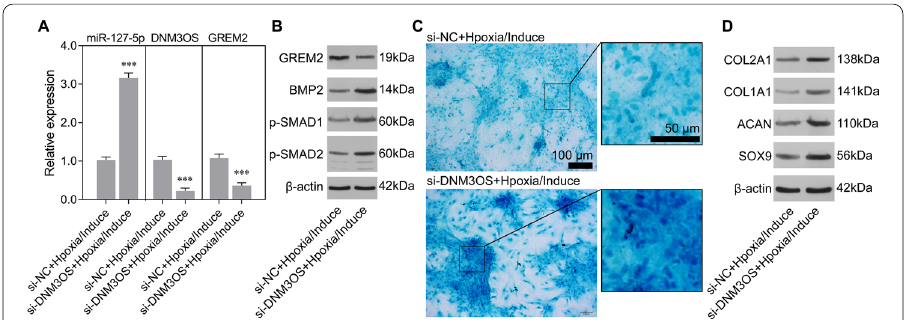
Fig. 7 DNM3OS knockdown weakened the inhibitory effect of hypoxia on chondrogenic induction. The rMSCs were transfected with si-DNM3OS, followed by induction of chondrogenic differentiation under hypoxic conditions (1% O 2 ) for 14 days. A Levels of miR-127-5p, DNM3OS, and GREM2 expression were determined by quantitative real-time PCR analysis. *** p < 0.001, compared with si-NC group. B Levels of GREM2, BMP2, p-SMAD1, and p-SMAD2 in rMSCs were detected by western blotting. C Images from Alcian blue staining assays of rMSCs. (D) Levels of COL1A1, COL2A1, SOX9, and ACAN protein expression were detected in rMSCs. si-NC: negative